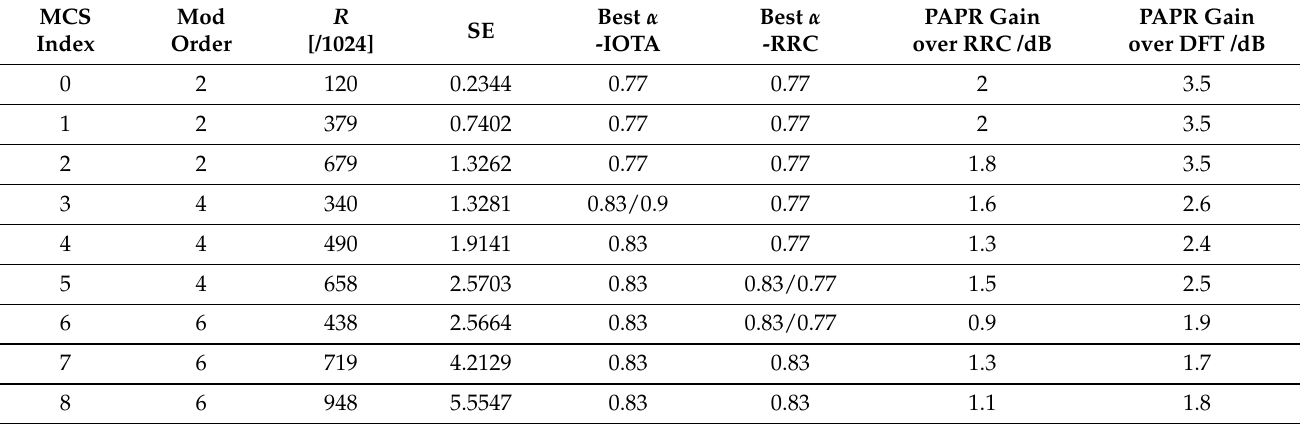
Table 3. PAPR gains under different MCS cases.